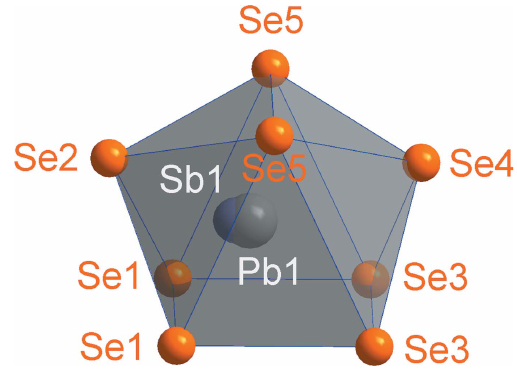
Figure 3 The coordination polyhedron of Pb1/Sb1. Colours as in Fig. 1